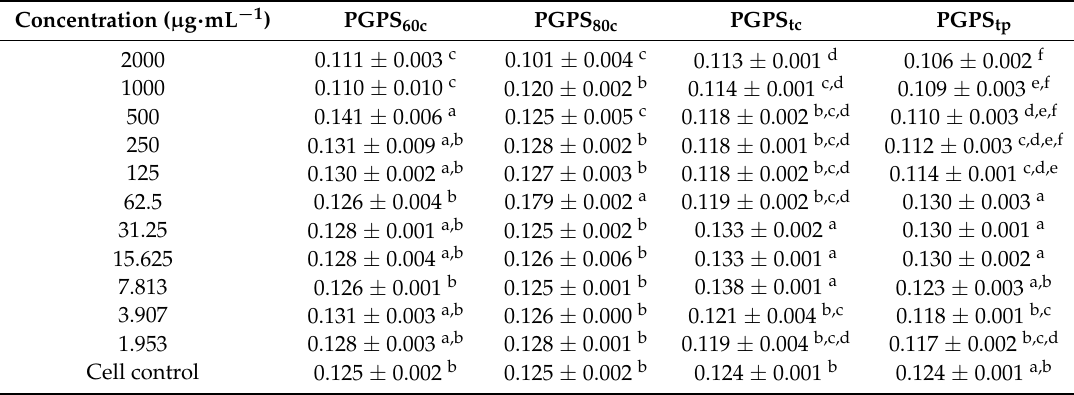
Table 1. OD 570 value of each polysaccharide group within 2000–1.953 µ g · mL − 1 ( n = 4).